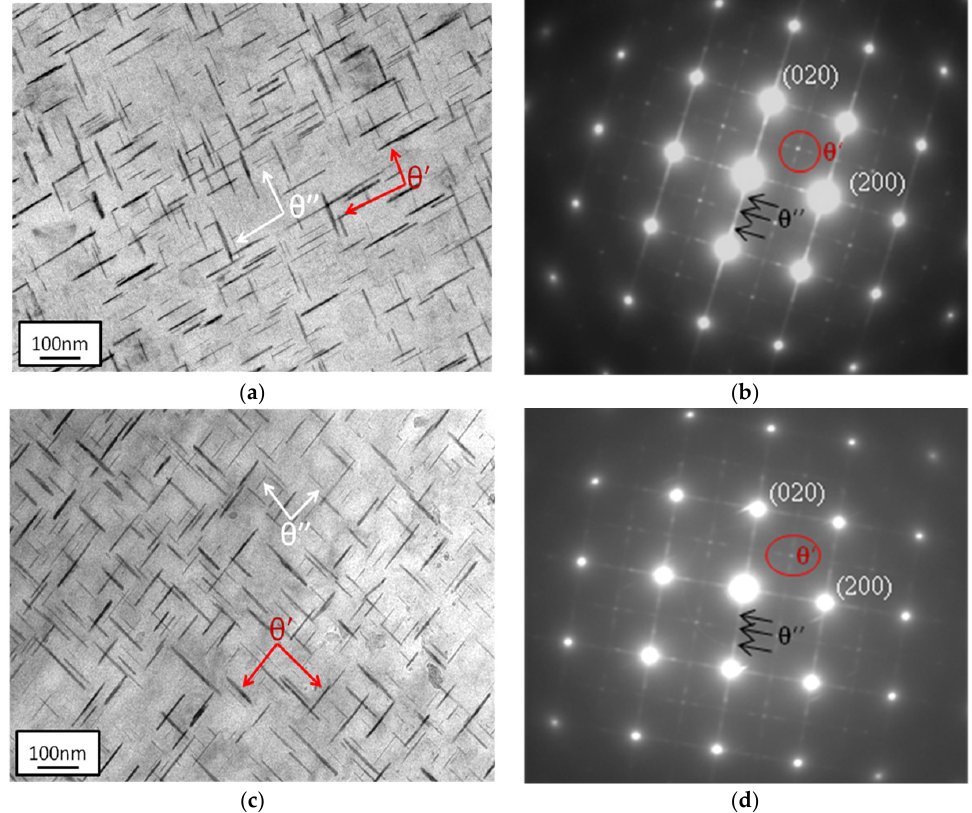
Figure 7. Transmission electron microscopy (TEM) images and corresponding diffraction spots obtained along the (100) Al zone axis of aged alloys with Fe contents: ( a , b ) 0.03 wt.% and ( c , d ) 0.20 wt.%.